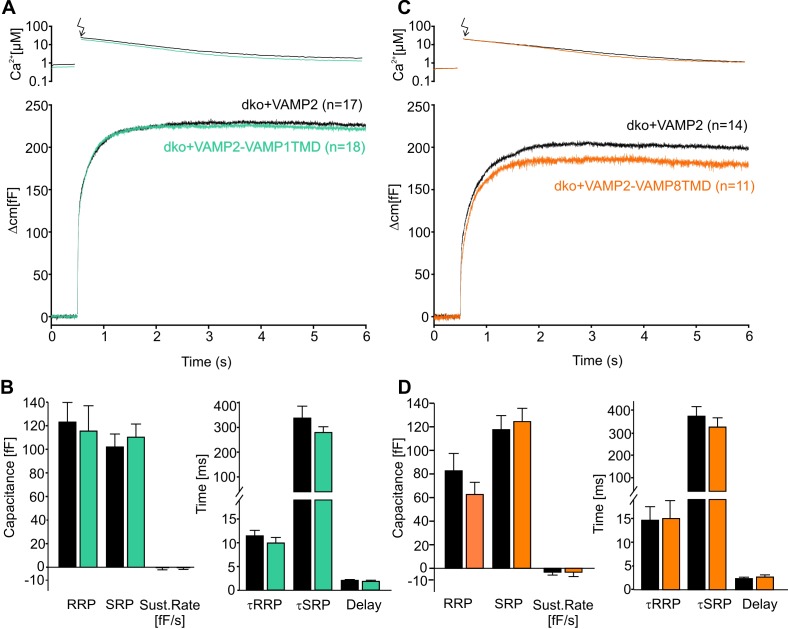
The naturally occurring v-SNARE TMD variants do not affect synchronous secretion.(A) Mean flash-induced [Ca2+]i levels (top panel) and corresponding CM responses (lower panels) of dko cells expressing either VAMP2 or the VAMP2-VAMP1TMD mutant. (B) The VAMP2-VAMP1TMD mutant fully restored the flash evoked response with an unchanged RRP, SRP and sustained rate of release. Neither the kinetics of release τRRP, τSRP nor the secretory delay was altered. (C) Mean flash-induced [Ca2+]i levels (top panel) and corresponding CM responses (lower panels) of dko cells expressing either VAMP2 or the VAMP2-VAMP8TMD. (D) Neither the extent (left panel) nor the kinetics of secretion (right panel) were altered with expression of the VAMP2-VAMP8TMD. Arrow indicates UV-flash. Data are represented as mean ± SEM and numbers of cells are indicated within brackets. Mann-Whitney Rank Sum test.